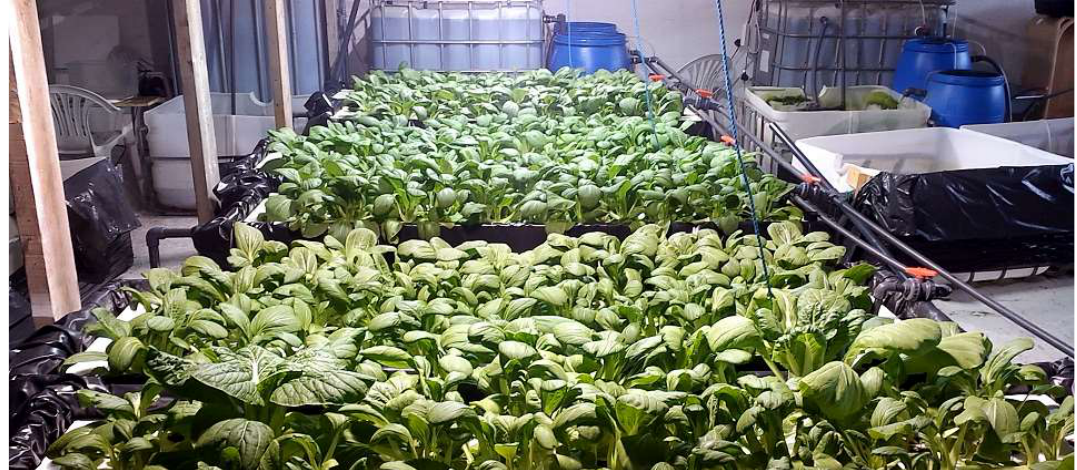
Figure 7. Growbeds in System 4 Trial 1 on the day of pak-choi harvest.